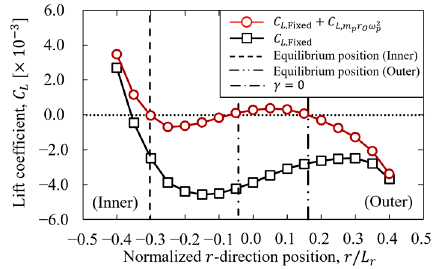
Figure 10. Lift coefficient acting on the particle for l = 400 cells, Re = 32 and C =